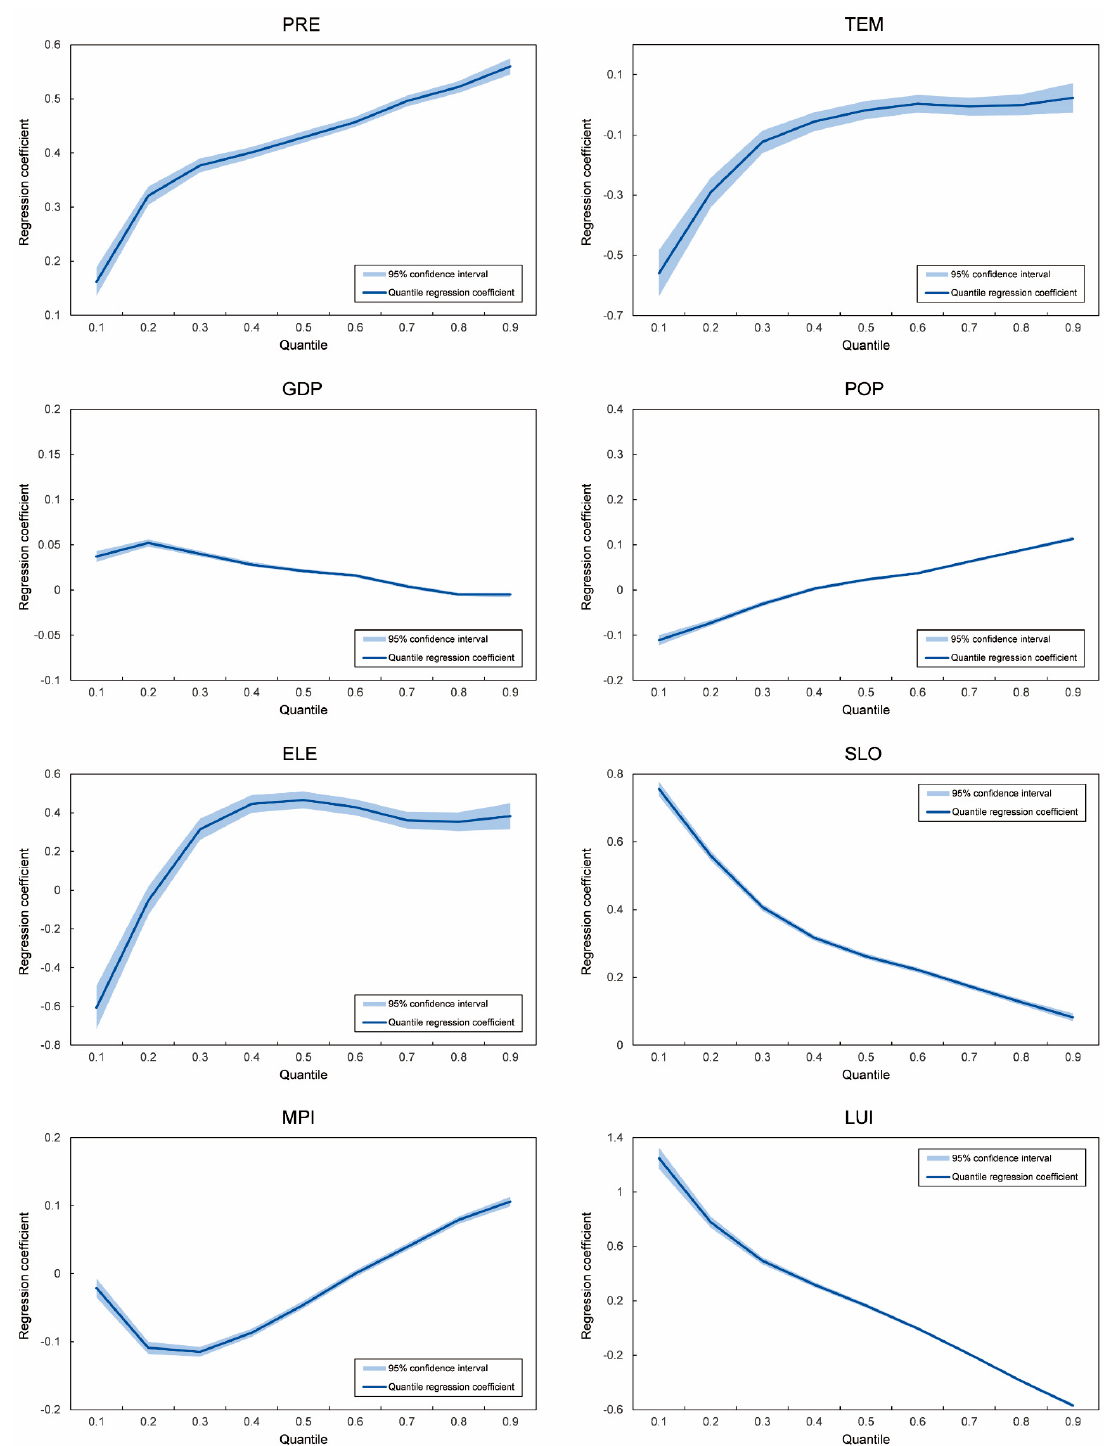
Figure 9. Quantile regression coefficients of influencing factors.